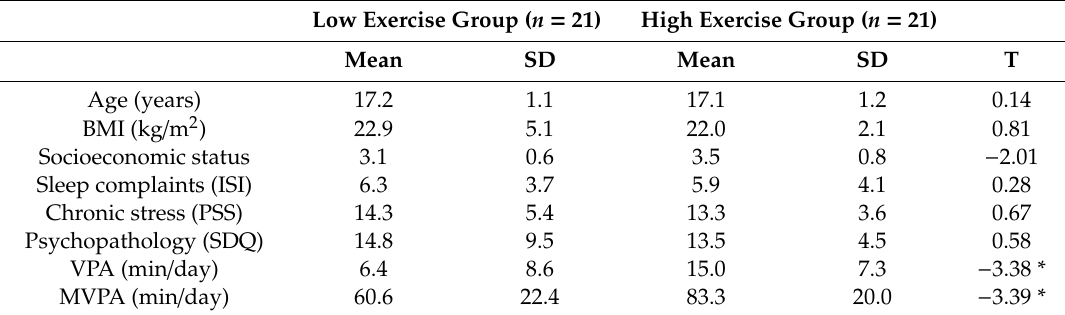
Table 1. Sample characteristics of high and low exercise